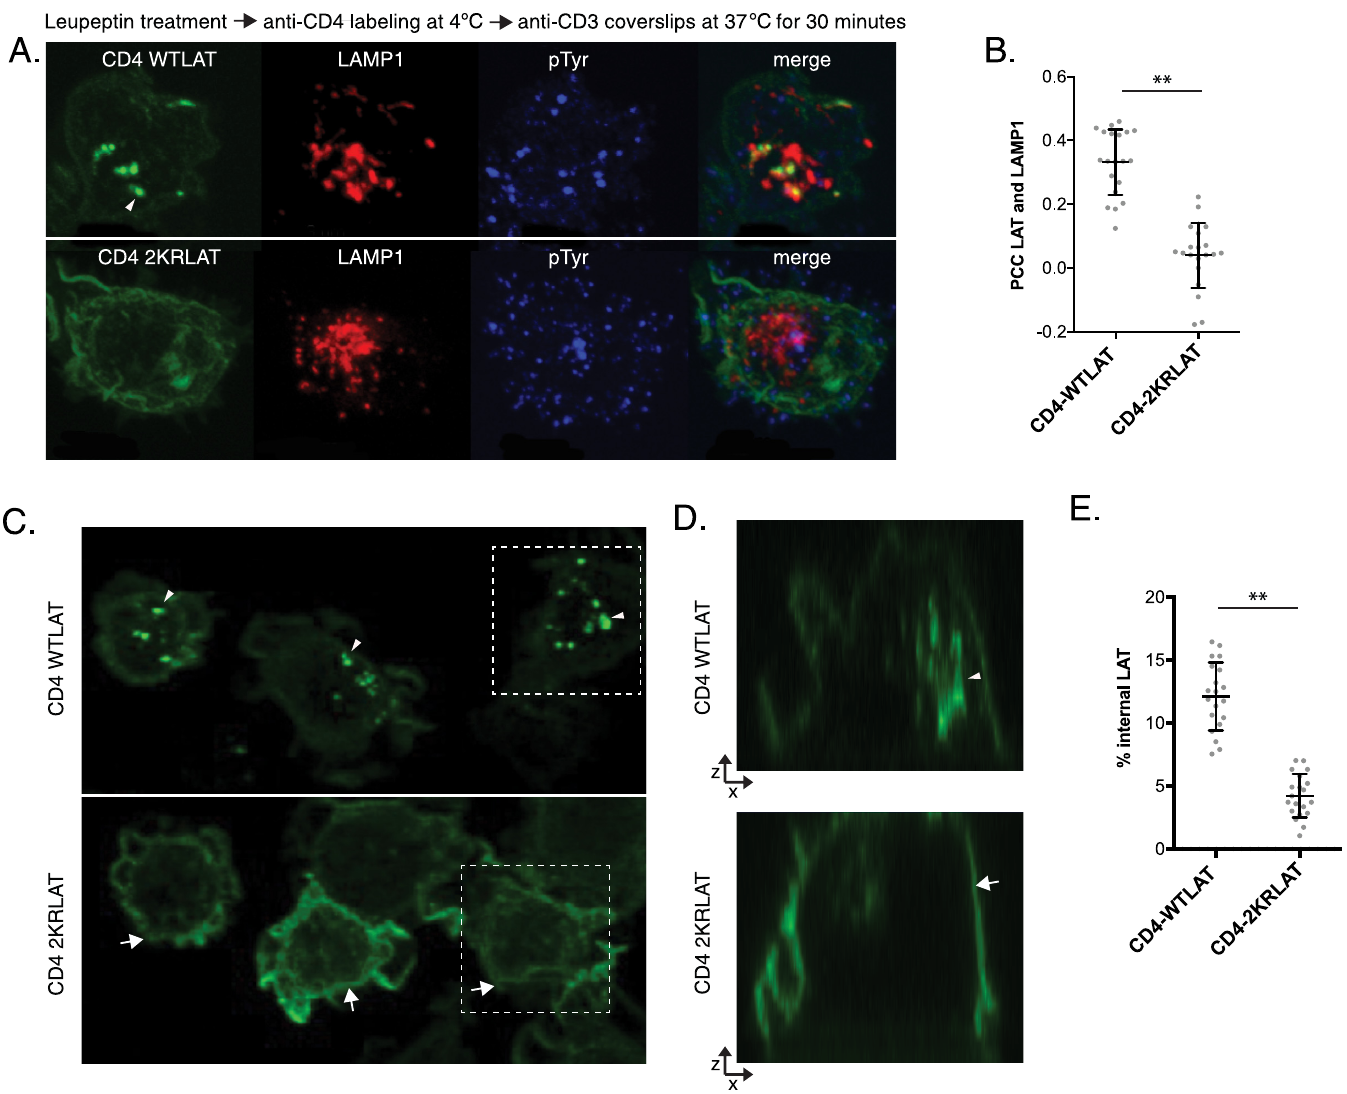
Fig 2. CD4-WTLAT traffics from the cell surface to the lysosome in activated cells. A . JCam2.5 cells stably expressing CD4-WTLAT or CD4-2KRLAT were treated with 1mg/ml Leupeptin for 4 hrs. Cells were then labeled with anti-CD4 (clone OKT4) at 4˚C, dropped onto stimulatory coverslips at 37˚C and fixed after 30 minutes. Post-fixation, cells were permeabilized and immunostained for LAMP1 and phosphotyrosine (pTyr). Data is representative of three independent experiments. B . Pearson colocalization coefficients between LAT and LAMP1 were quantified. Each symbol denotes an individual cell and bars denote means ± SD for each group. C . JCam2.5 cells stably expressing CD4-WTLAT or CD4-2KRLAT were treated with 1mg/ml Leupeptin for 4 hrs. Cells were then labeled with anti-CD4 (clone OKT4) at 4˚C, dropped onto stimulatory coverslips at 37˚C and fixed after 30 minutes. Confocal slices 0.5 μ m apart were collected through the entire cell. D . x-z view of the cells outlined in white in C. Data is representative of three independent experiments. In A , C and D arrowheads indicate internal LAT pools and arrows indicate LAT at the cell surface. E . % internal CD4-LAT levels were calculated. Each symbol denotes an individual cell and bars denote means ± SD for each group. Statistical significance was determine using Student’s t test. �� p <